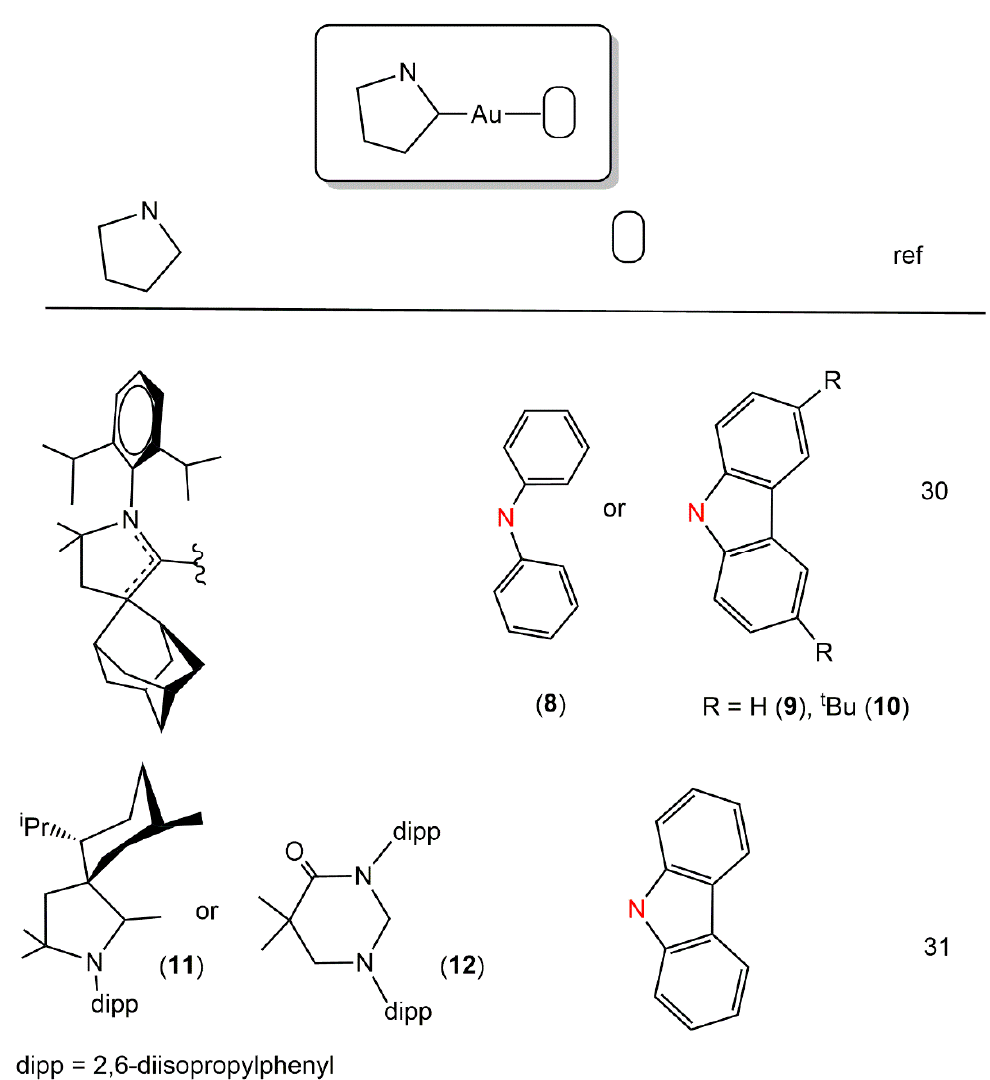
Figure 6. Chemical structure of carbine-Au(I) derivatives that display TADF properties. Coordinating atoms are marked in red.